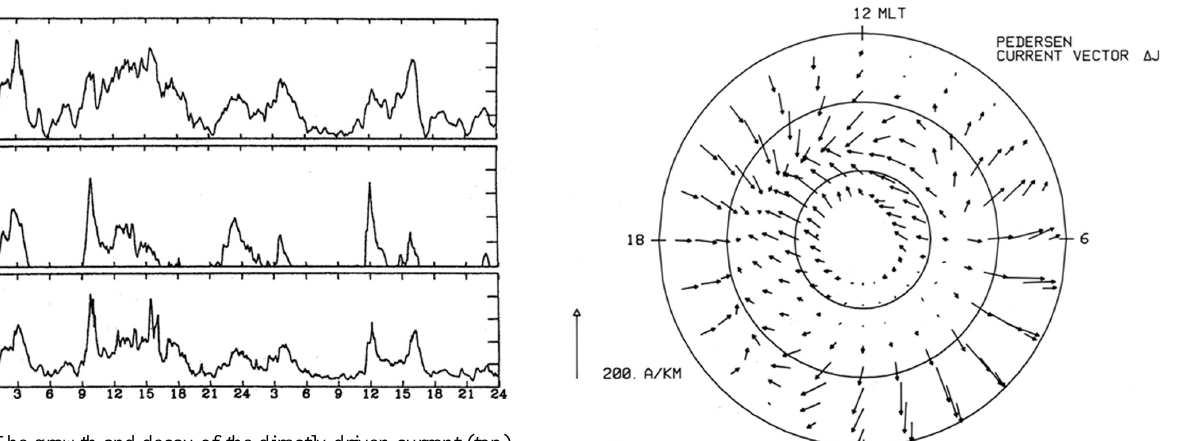
Fig. 9d. The growth and decay of the directly driven current (top), the unloading component (middle), and the total current (bottom) during a series of substorms (Sun et al., 1998).